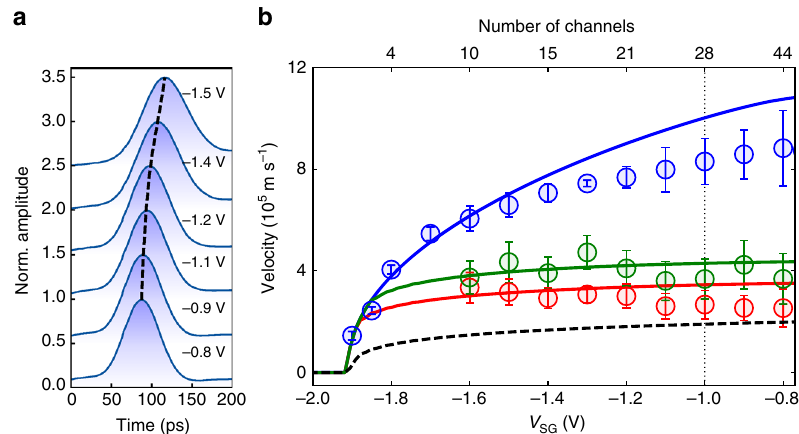
Fig. 2 Tuning the propagation velocity. a Time-resolved measurements of the electron pulse for different con fi nement potentials at QPC 3 position. The curves have been offset vertically for clarity. b Velocity of the electron pulse as a function of the con fi nement potential and the corresponding number of channels. Open circles: experimental data, solid lines: parameter-free self-consistent calculation. The blue data points correspond to the situation where the channel selection QPC 0 is not activated. The red (green) data are obtained by setting the channel selection QPC 0 at a conductance value of G = 2 e 2 / h ( G = 4 e 2 / h ). The red (green) solid line corresponds to the velocity of the fast plasmon mode for a one-channel (two-channel) Tomonaga – Luttinger liquid. The black dashed line corresponds to the non-interacting Fermi liquid. The vertical dotted line indicates the gate voltage at which the velocities of Fig. 3d are taken. The errors bars correspond to the velocity uncertainty and are derived from a linear fi t of the QPC distance versus the respective time-of- fl ight (c.f. Supplementary Note